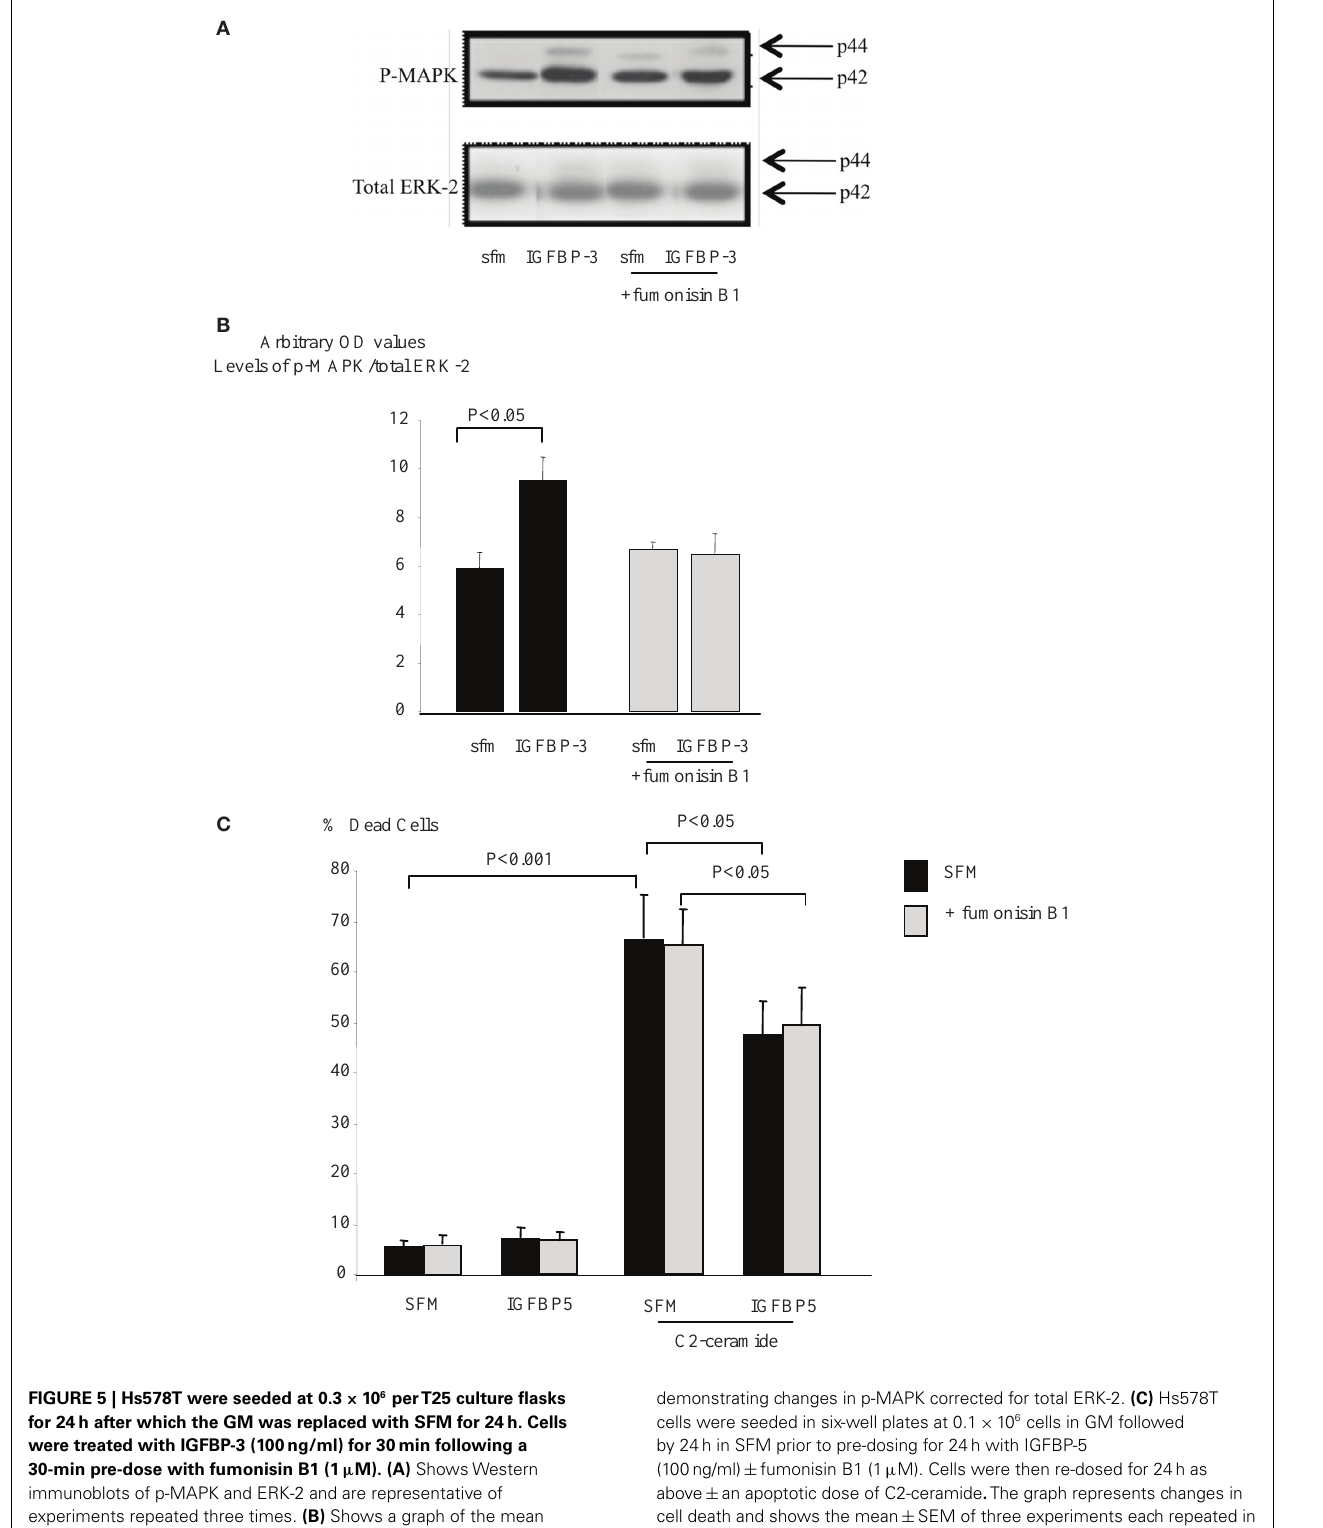
FIGURE 5 | Hs578T were seeded at 0.3 × 10 6 perT25 culture flasks for 24h after which the GM was replaced with SFM for 24h. Cells were treated with IGFBP-3 (100ng/ml) for 30min following a 30-min pre-dose with fumonisin B1 (1 μ M). (A) ShowsWestern immunoblots of p-MAPK and ERK-2 and are representative of experiments repeated three times. (B) Shows a graph of the mean arbitrary optical density measurements from three experiments